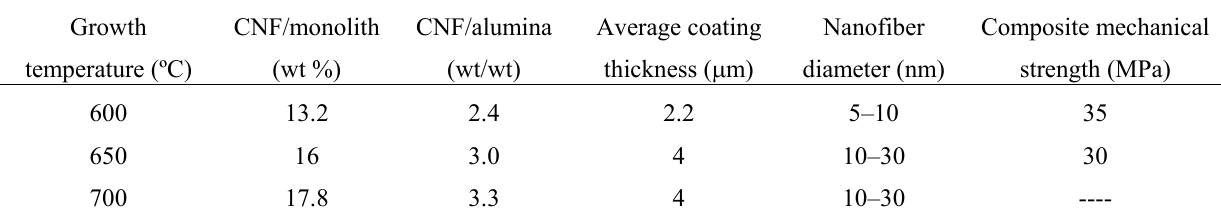
Table 1. Characterization of the CNF coating on composite monoliths after growing with H /H mixture at different temperatures. From reference [29], with permission from C 2 6 2